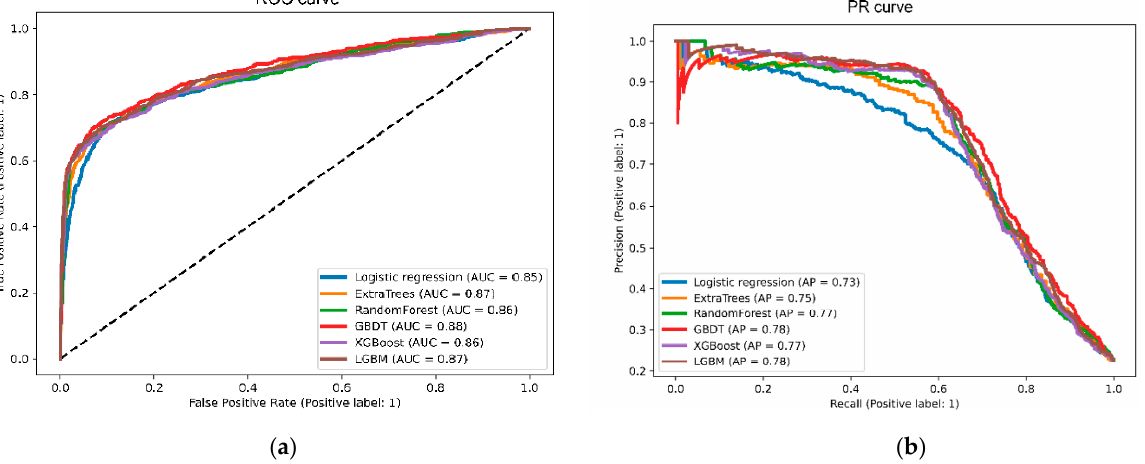
Figure 2. Receiver operating characteristic curves ( a ) and precision–recall curves ( b ) of machine learning models. GBDT yielded the highest area under the receiver operating characteristic curve and average precision, followed by LGBM and extra trees. Abbreviations: ROC—receiver operating characteristic; AUC—area under the curve; GBDT—gradient boosting decision tree; XGBoost—extreme gradient boosting; LGBM—light gradient boosting machine; PR—precision–recall; AP—average precision.